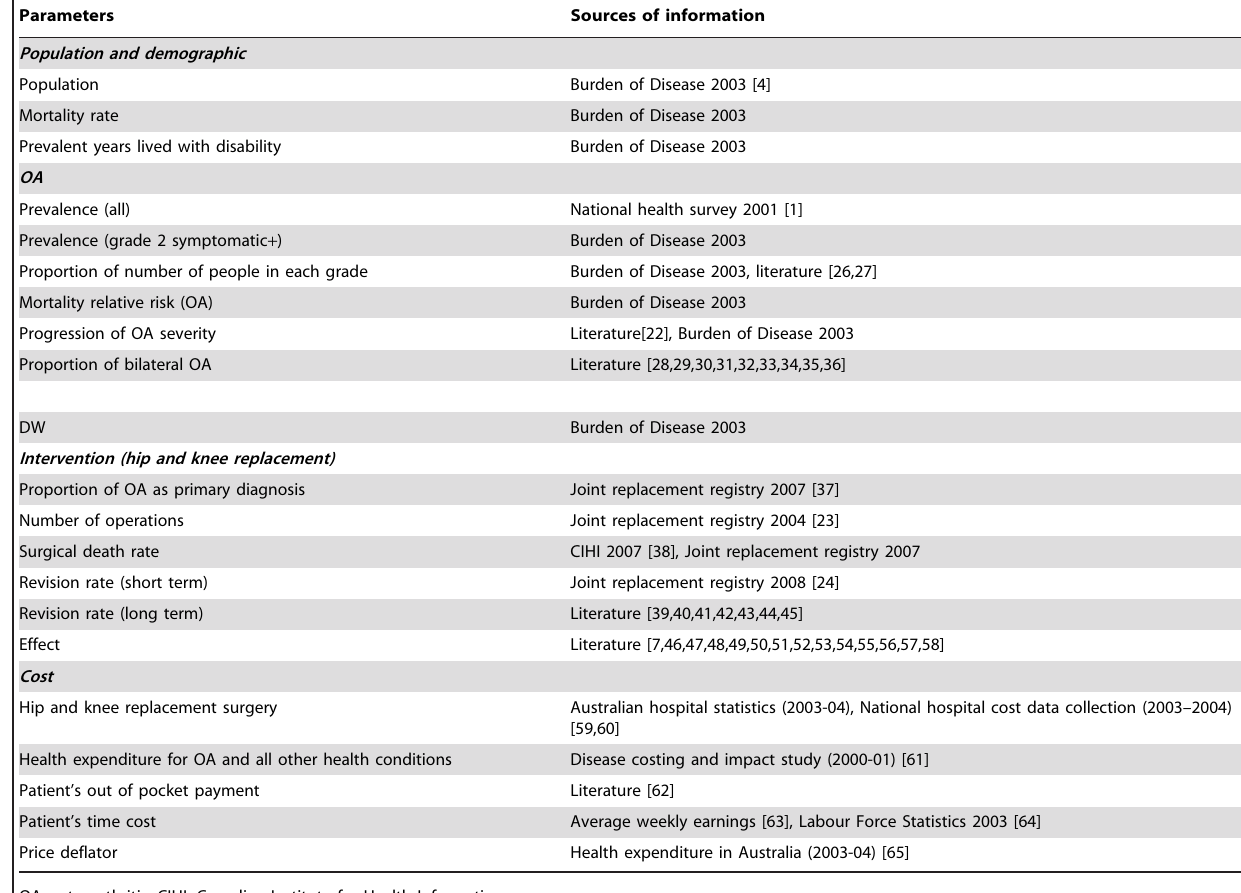
Table 1. Data sources.